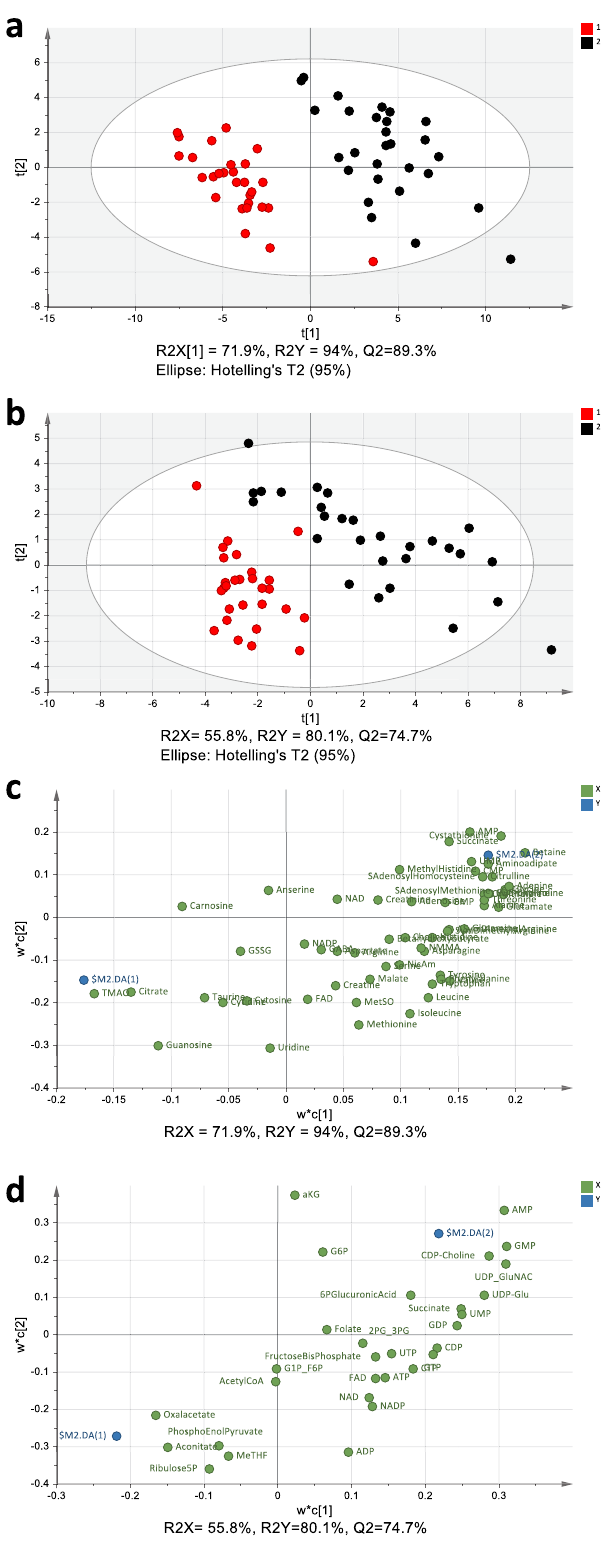
(Fig. 10e, f) of colorectal tumors among any of the four genotypes,